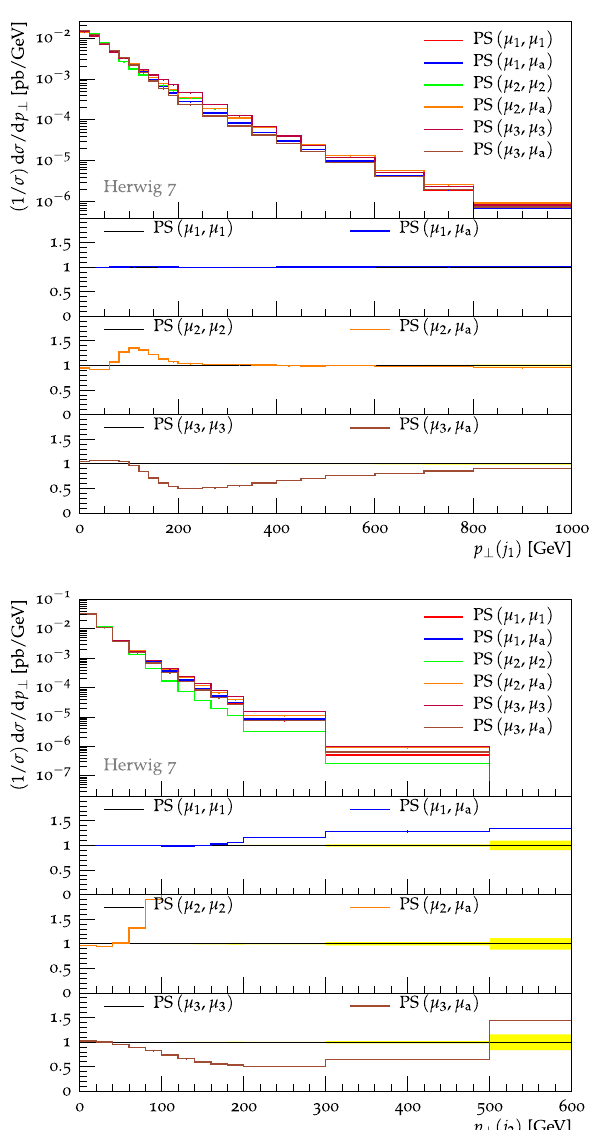
Fig. 13 Theeffectofdifferentchoicesofthehardvetoscale Q ⊥ forthe two shower algorithms, angular ordered (PS) and dipole (DS), respec- tively when using MC@NLO-type matching. We compare predictions for different choices of the resummation and factorization scale choice μ H , using two choices for the hard veto scale in each case. The scales